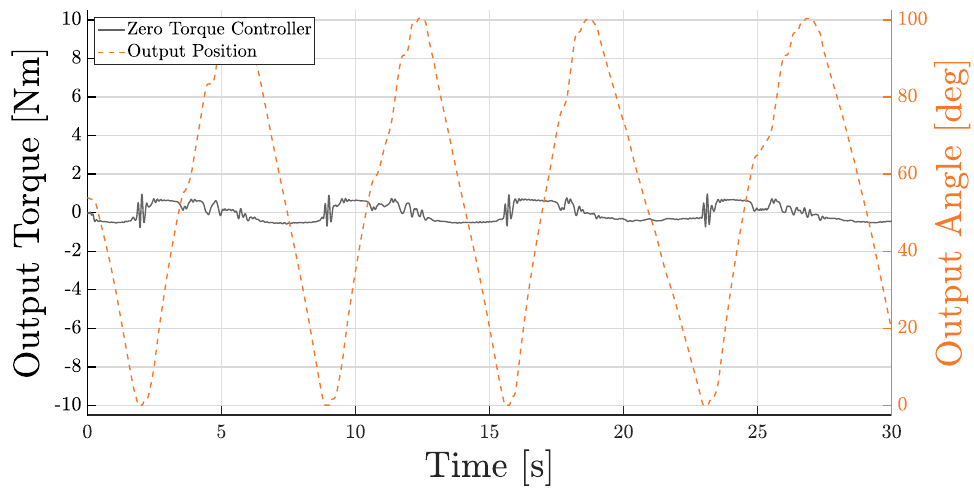
Figure 17. Zero-torque controller realised with the SMARCOS. The output arm is actuated over the whole range of motion while the output torque remains contained between [ − 1;1] Nm. The controller helps the user to overcome the back-driving torque of the actuator given in Table 2.